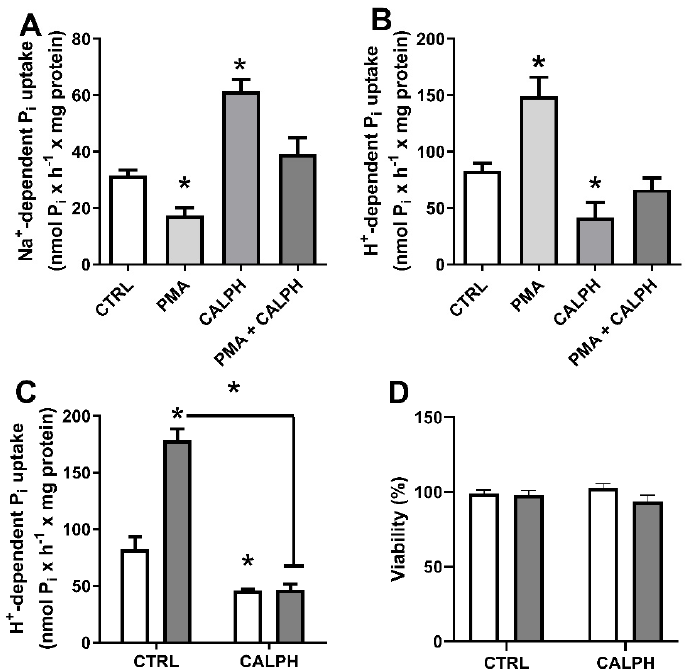
Figure 10. Role of PKC in modulation of Pi uptake. Na + -dependent ( A ) or H + -dependent ( B ) Pi up- take were performed for 1 h in the presence of PKC stimulator PMA (1 nM), PKC inhibitor Cal- phostin C (CALPH:50 nM) or PMA plus CALPH as indicated. MDA-MB-231 cells were treated with 1 mM Pi (white bars) or 8 mM Pi (grey bars) in the absence (control) or presence of CALPH (50 nM) for 24 h and H + -dependent Pi uptake ( C ) and cell viability ( D ) were performed as indicated in Sec- tion 4. The results are mean ± SE of at least 3 independent biological samples. * p < 0.05 indicates changes significantly different, as assessed by ANOVA followed by Tukey’s multiple comparison test.